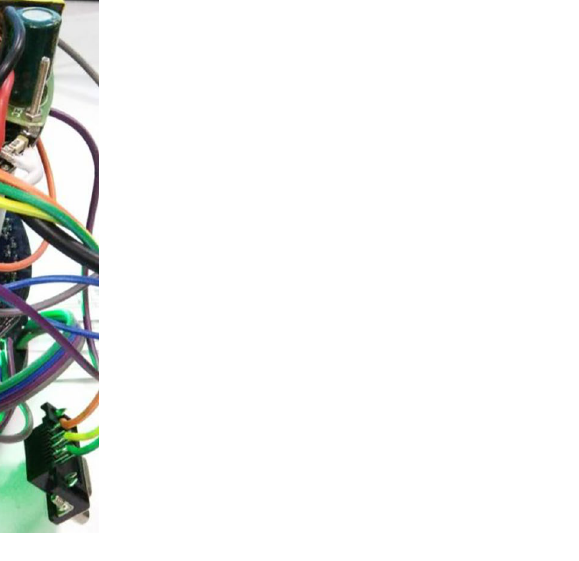
Figure 6. Physical diagram of